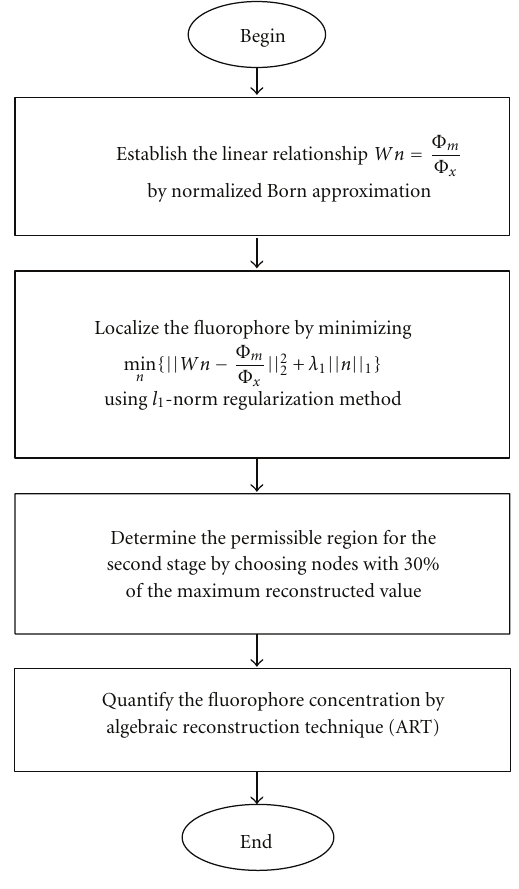
Figure 1: Flowchart of the proposed algorithm.